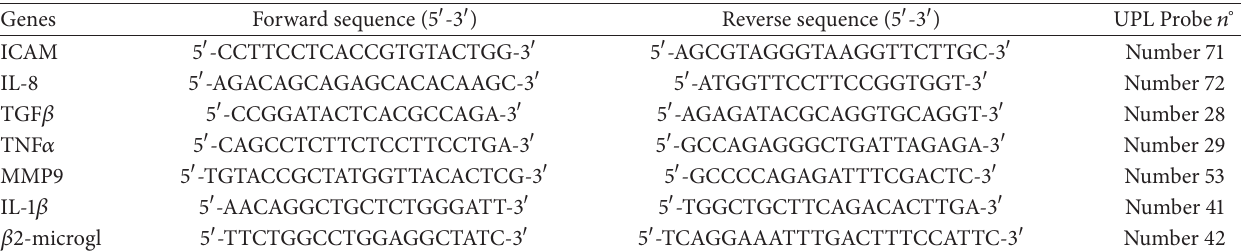
Table 1: Sequence of “UPL” primers used for